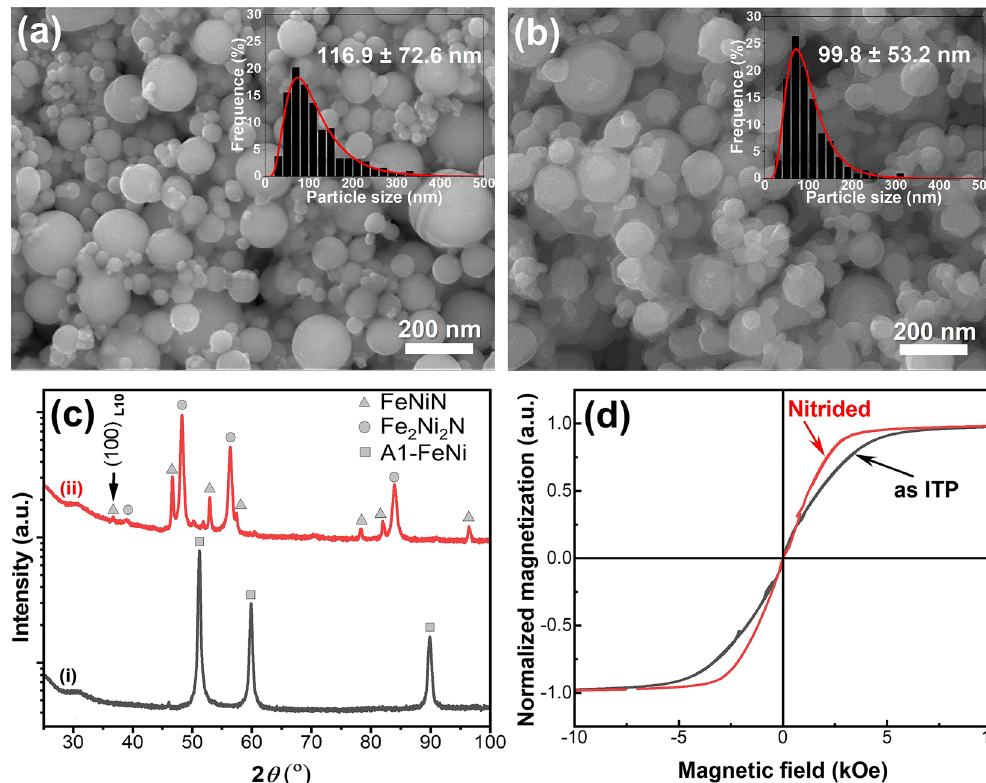
Figure 2. Microstructure evolution before and after the nitriding process. ( a , b ) FE-SEM images and ( c ) XRD profiles of the ( a , c - i ) as induction thermal plasma processed (as ITP) and ( b , c-ii ) nitrided FeNi NPs. ( d ) Magnetic hysteresis curves (room temperature) of the as ITP and nitrided FeNi NPs. Insets in the FE-ESEM images show the corresponding particle size